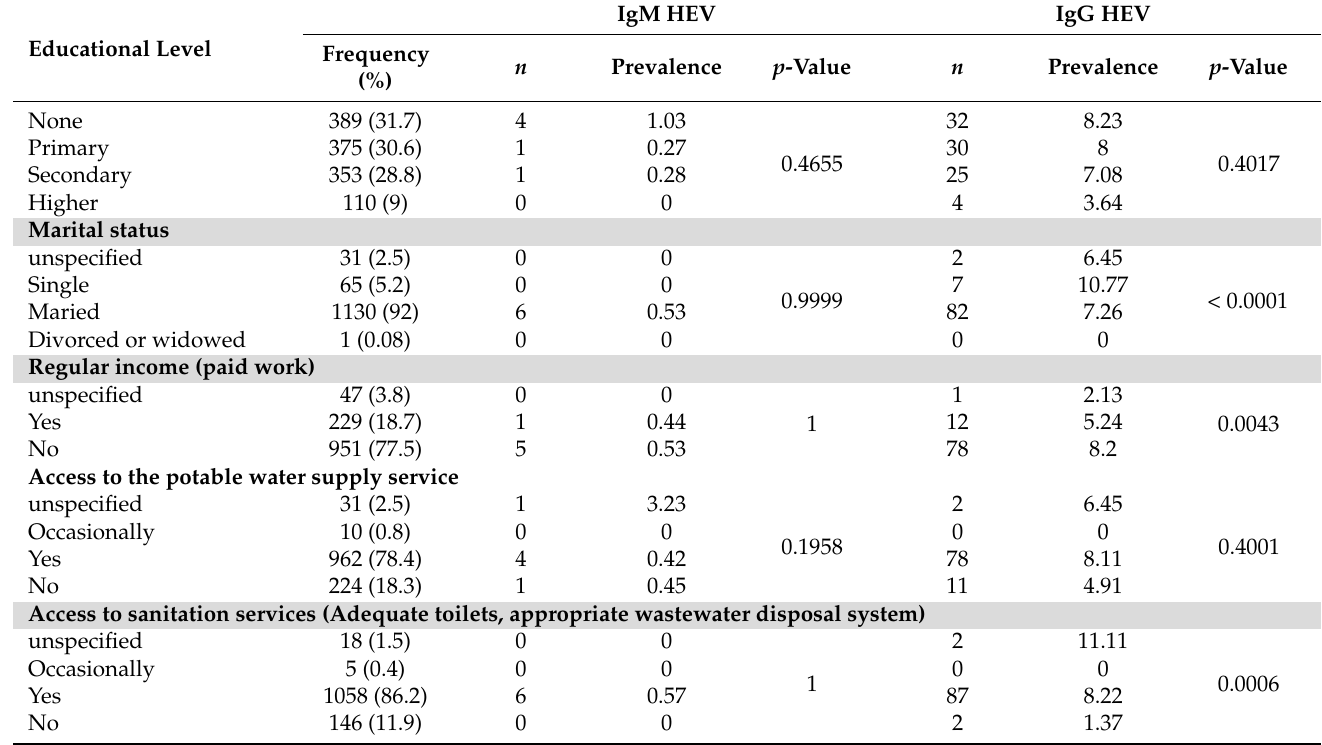
Table 3. Prevalance of HEV IgM and IgG markers and potential associated